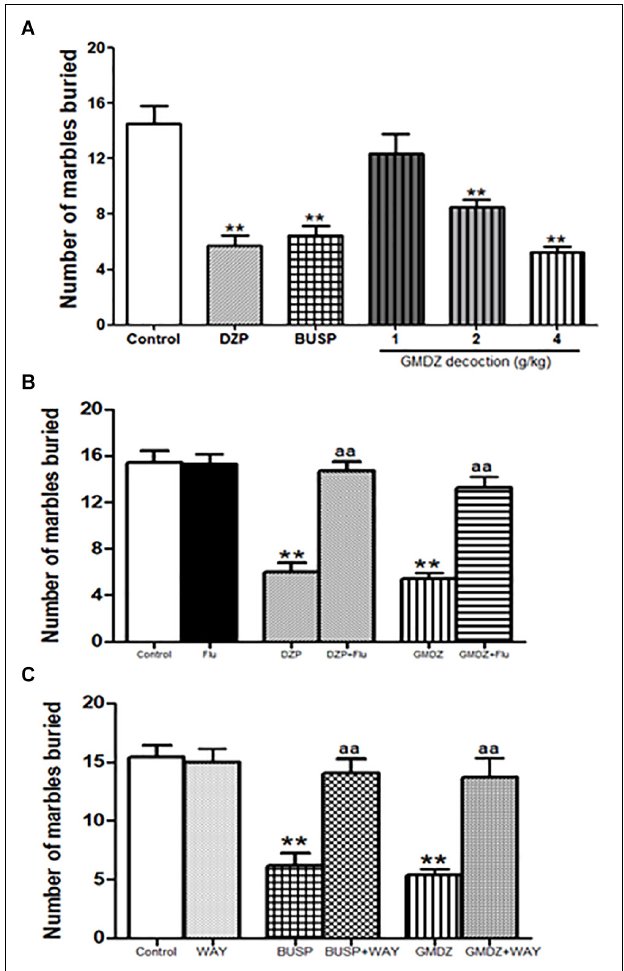
FIGURE 7 | Effect of GMDZ decoction and receptor antagonist on the number of marbles buried in the MB test. (A) Effect of GMDZ decoction on the MB test. (B) Effect of Flu on the numbers of marbles buried. (C) Effect of WAY on the number of marbles buried. Value are represented as mean ± SEM ( n = 12). ∗∗ P < 0.01 vs. control group; One way ANOVA with Student–Newman–Keuls post hoc test. a P < 0.05 or aa P < 0.01 treatment vs.